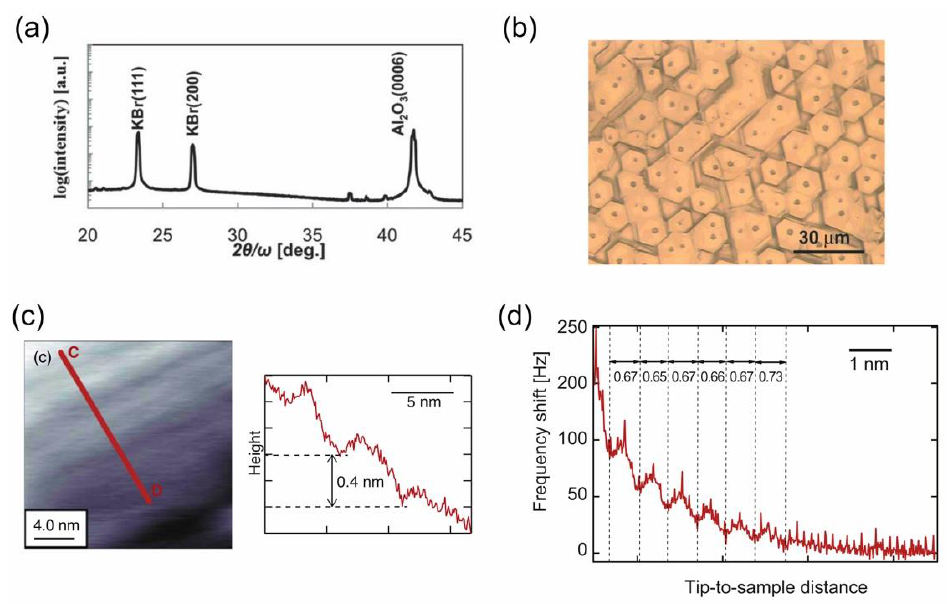
Figure 10. The out-of-plane XRD pattern ( a ) and optical microscope image ( b ) of an IL-VLS grown KBr(111) film on an α -Al 2 O 3 (0001) substrate. Reproduced with permission from ref. [30]. Copyright 2016, The Royal Society of Chemistry. ( c ) FM-AFM topographic image of the KBr(111) film observed in [bmim][PF 6 ] IL, together with the line profile along the c-d red line. ( d ) Δ f (frequency shift) versus tip-to-sample distance curve obtained on the KBr film in [bmim][PF 6 ] IL by FM-AFM measurement. Reproduced with permission from ref. [56]. Copyright 2022, IOP Publishing Ltd.